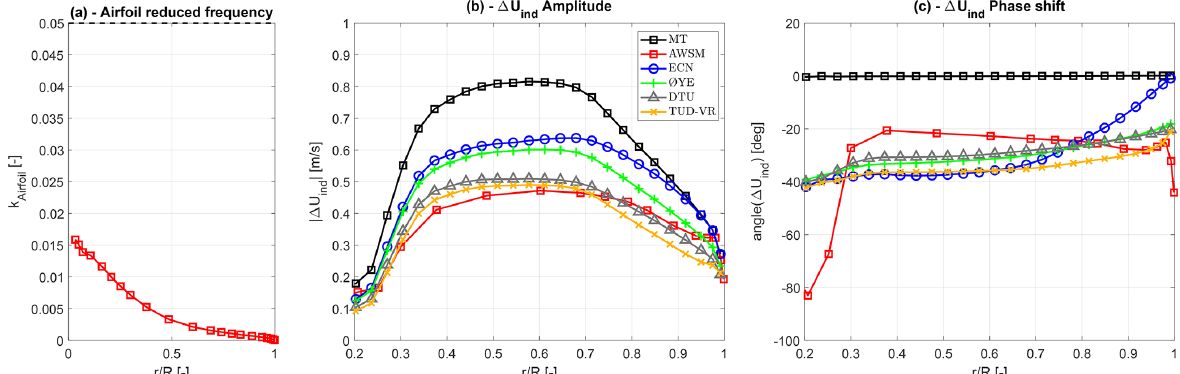
Figure 6. Spanwise distributions for the 10mHz sinusoidal pitch variation near rated conditions (a) of the reduced airfoil frequency; (b) of the axial induced-velocity variation amplitude at the blade pitch frequency; and (c) of the axial induced-velocity variation phase at the blade pitch frequency, with respect to the phase of the prescribed pitch time series.